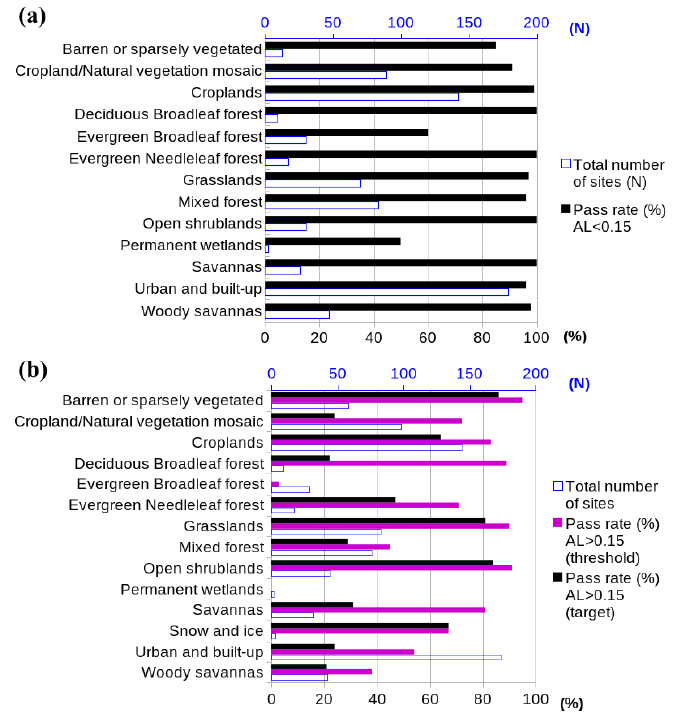
Figure 11. Pass rate for VGT per land cover type using the MODIS Land Cover product and MODIS as a reference. Results are given for the two regimes of surface albedo values: ( a ) Lower than 0.15; and ( b ) greater than 0.15. ‘Threshold’ and ‘Target’ levels of requirements are indicated in Table